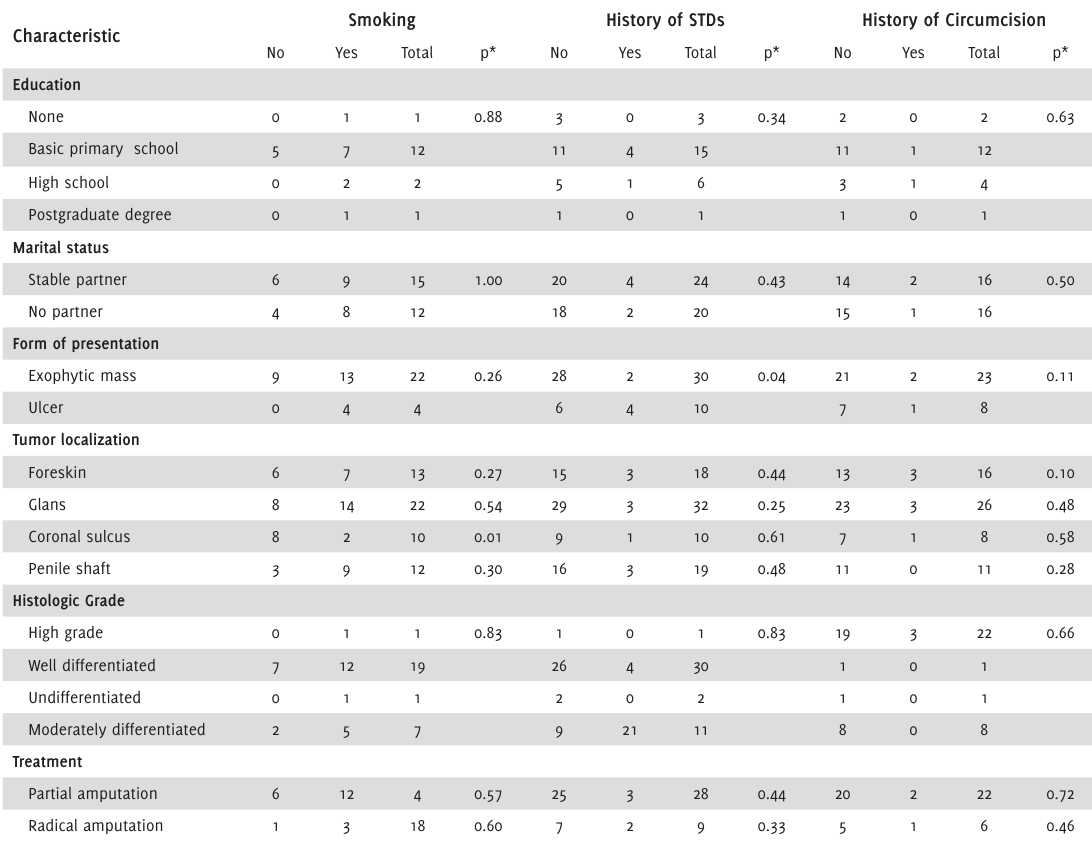
Table 1. Relationship between Past Medical History and Sociodemographic and Clinical Characteristics of Patients with Penile Cancer Diagnosis in a Tertiary Referral Hospital in Cali, Colombia,